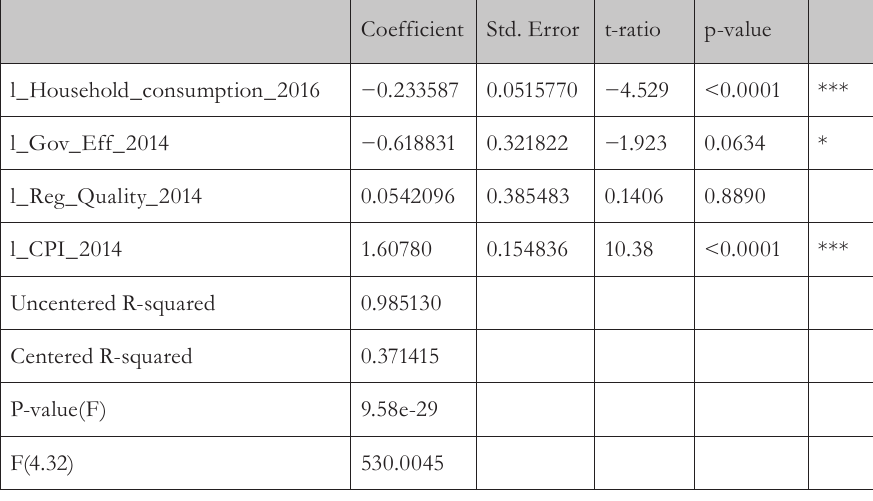
Tab. 4 – Regression analysis, method OLS, dependent variable: l_EP_2016 (N=36).